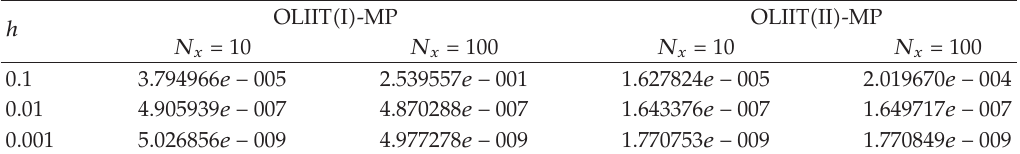
Table 9: The errors (cid:16) at t (cid:5) 10 when the algorithms are applied to the problem (cid:3) 5.6 (cid:4) with the coe ffi cients group II, where τ (cid:3) t (cid:4) (cid:5) 0 . 5 t .